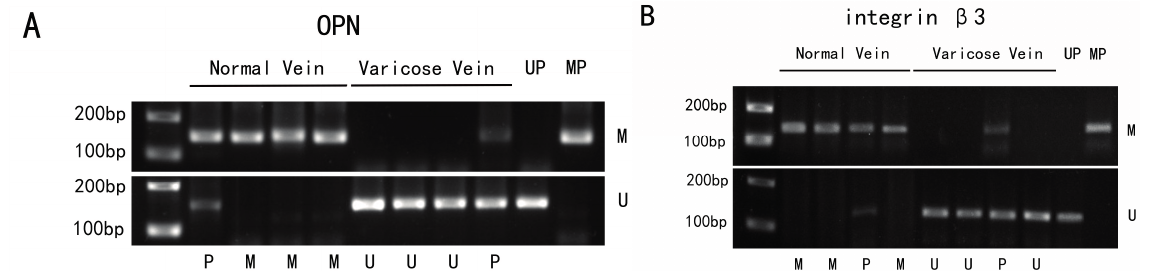
Figure 6. Differences in OPN and integrin β 3 gene promoter methylation in vein specimens. ( A ) Methylation specific PCR (MSP) analysis of OPN gene promoter methylation in vein specimens; ( B ) MSP analysis of integrin β 3 gene promoter methylation in vein specimens. Methylation, unmethylation, unmethylation positive control, methylation positive control and partial methylation are simply labeled as M, U, UP, MP, and P, respectively.